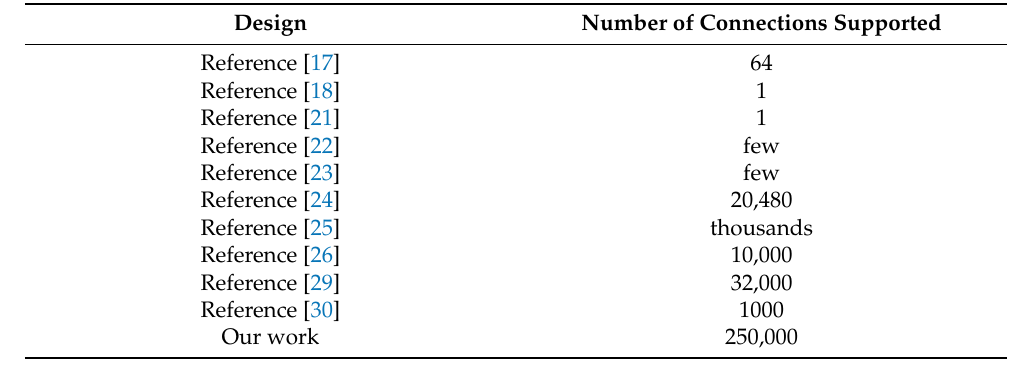
Table 1. Comparison of the TOE of this design with previous